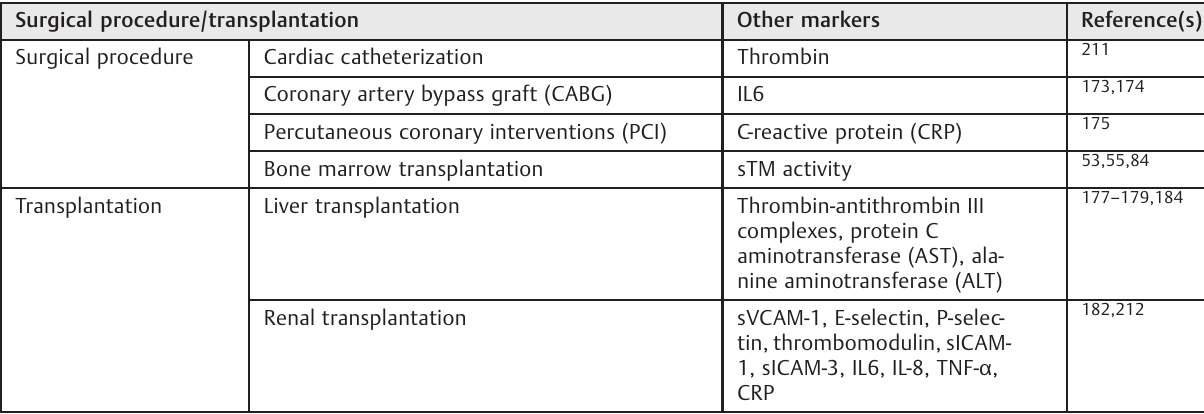
Abbreviations: IL, interleukin; sTM, soluble thrombomodulin; sICAM, soluble intercellular adhesion molecule-1; TNF, tumor necrosis